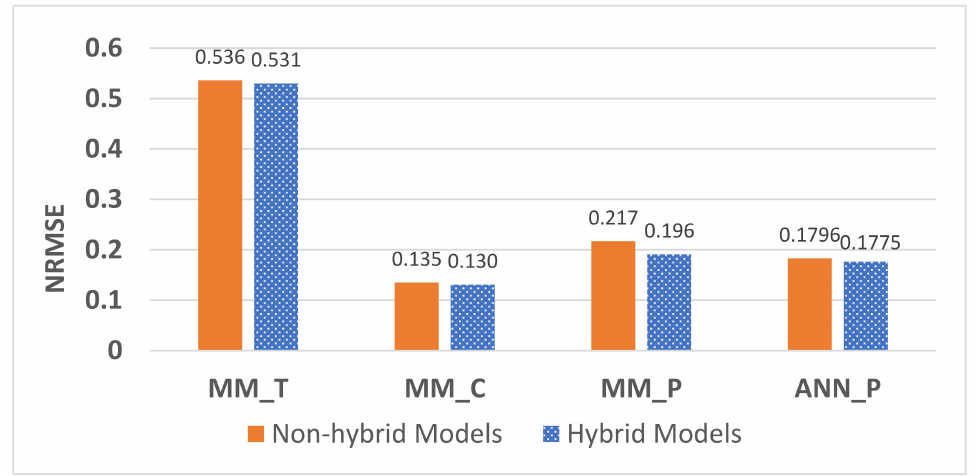
Figure 11. NRMSE comparison among non-hybrid and hybrid